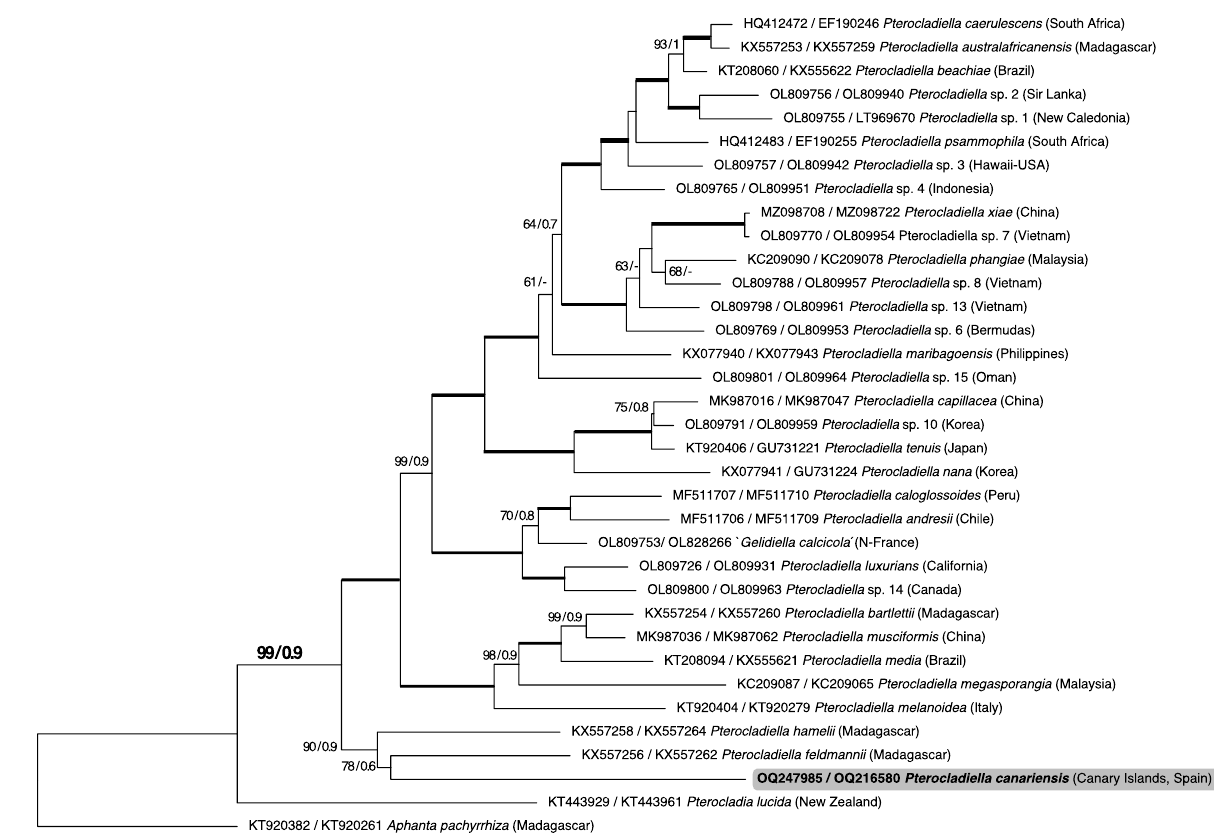
Figure 3. Maximum likelihood (ML) concatenated tree of 35 (2686 bp) cox 1 and rbc L sequences calculated using the GTR+I+G evolution model. ML bootstrap values ≥ 60 and Bayesian inference posterior probability values ≥ 0.8 are shown for each branch. Black bold lines indicate full support in both analyses.